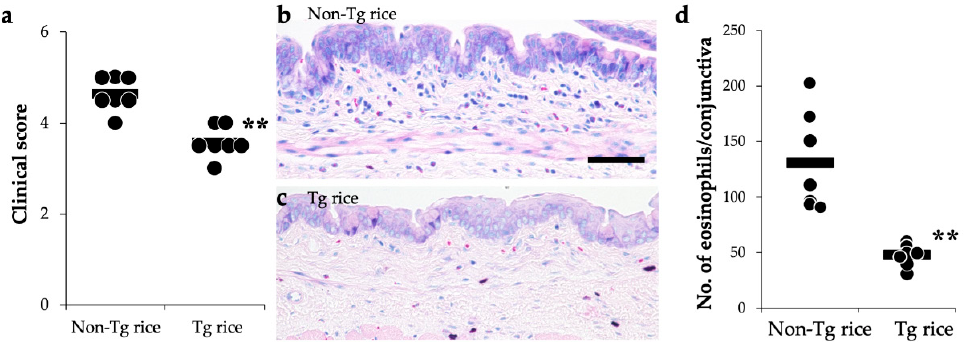
Figure 5. Therapeutic administration with Tg rice suppresses the development of EAC. Mice were fed Tg rice seed or control (non-Tg) rice seed ad libitum for 17 d after the sensitization with birch pollen. At 20 min after the last birch pollen challenge, clinical appearances were evaluated. ** p < 0.01, Tg vs. Non-Tg rice-fed group according to unpaired Student’s t test (seven mice per group) ( a ). At 24 h after the third challenge, the eyes were isolated for histological analysis of the number of eosinophils in the conjunctiva ( b – d ). ** p < 0.01, Tg vs. Non-Tg rice-fed group according to the Mann–Whitney U test (seven mice per group). The dots and bars within ( a , d ) indicate mean values for the two eyes of each mouse and the overall median values, respectively.